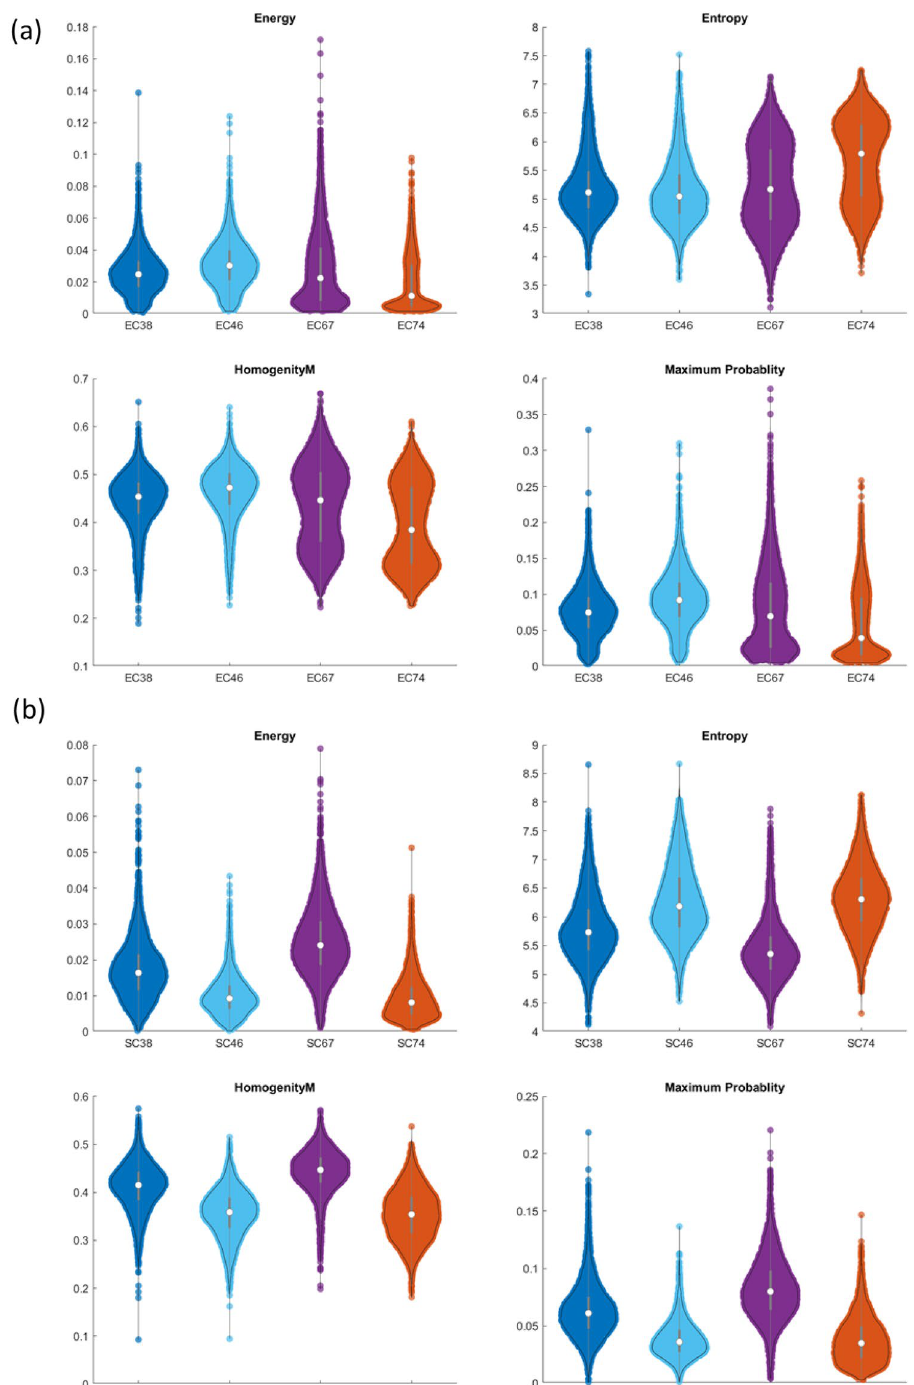
Figure 4. Harlick texture and geometrical features comparison of LEC and HSC healthy vs diseased cells using 2D transmission image. ( a ) Haralick texture feature comparisons such as energy, entropy, homogeneity and maximum probability of LEC healthy vs diseased cells (EC38, EC67 vs EC46, EC74) using 2D transmission image. ( b ) Haralick texture feature comparisons such as energy, entropy, homogeneity and maximum probability of HSC healthy vs diseased cells (SC38, SC67 vs SC46, SC74) using 2D transmission